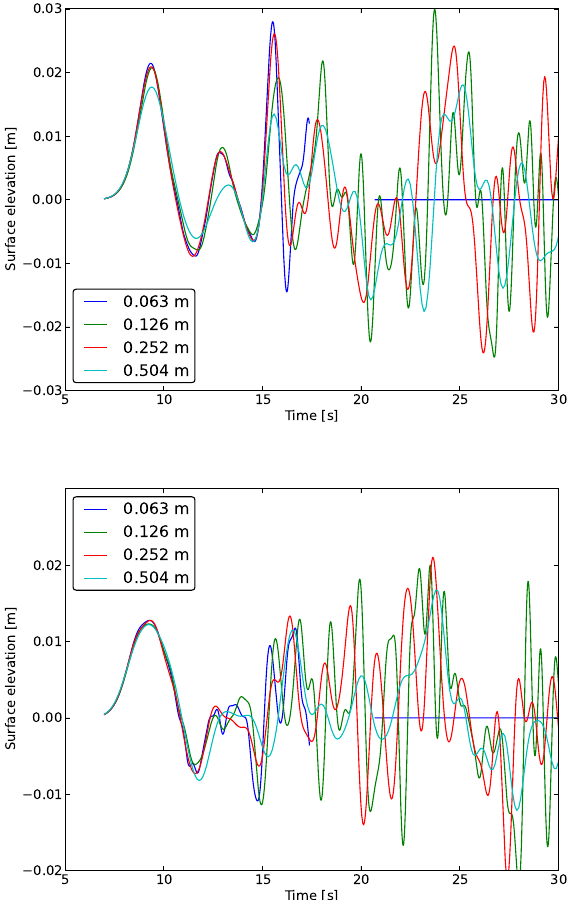
Figure 9. Convergence tests for tsunami inundation using MOST (nested with GloBouss). The surface elevation (marigrams) at gauges UG1 (upper panels) and UH6 (lower panels) is given as a function of time. The labels refer to the spatial grid resolution of each